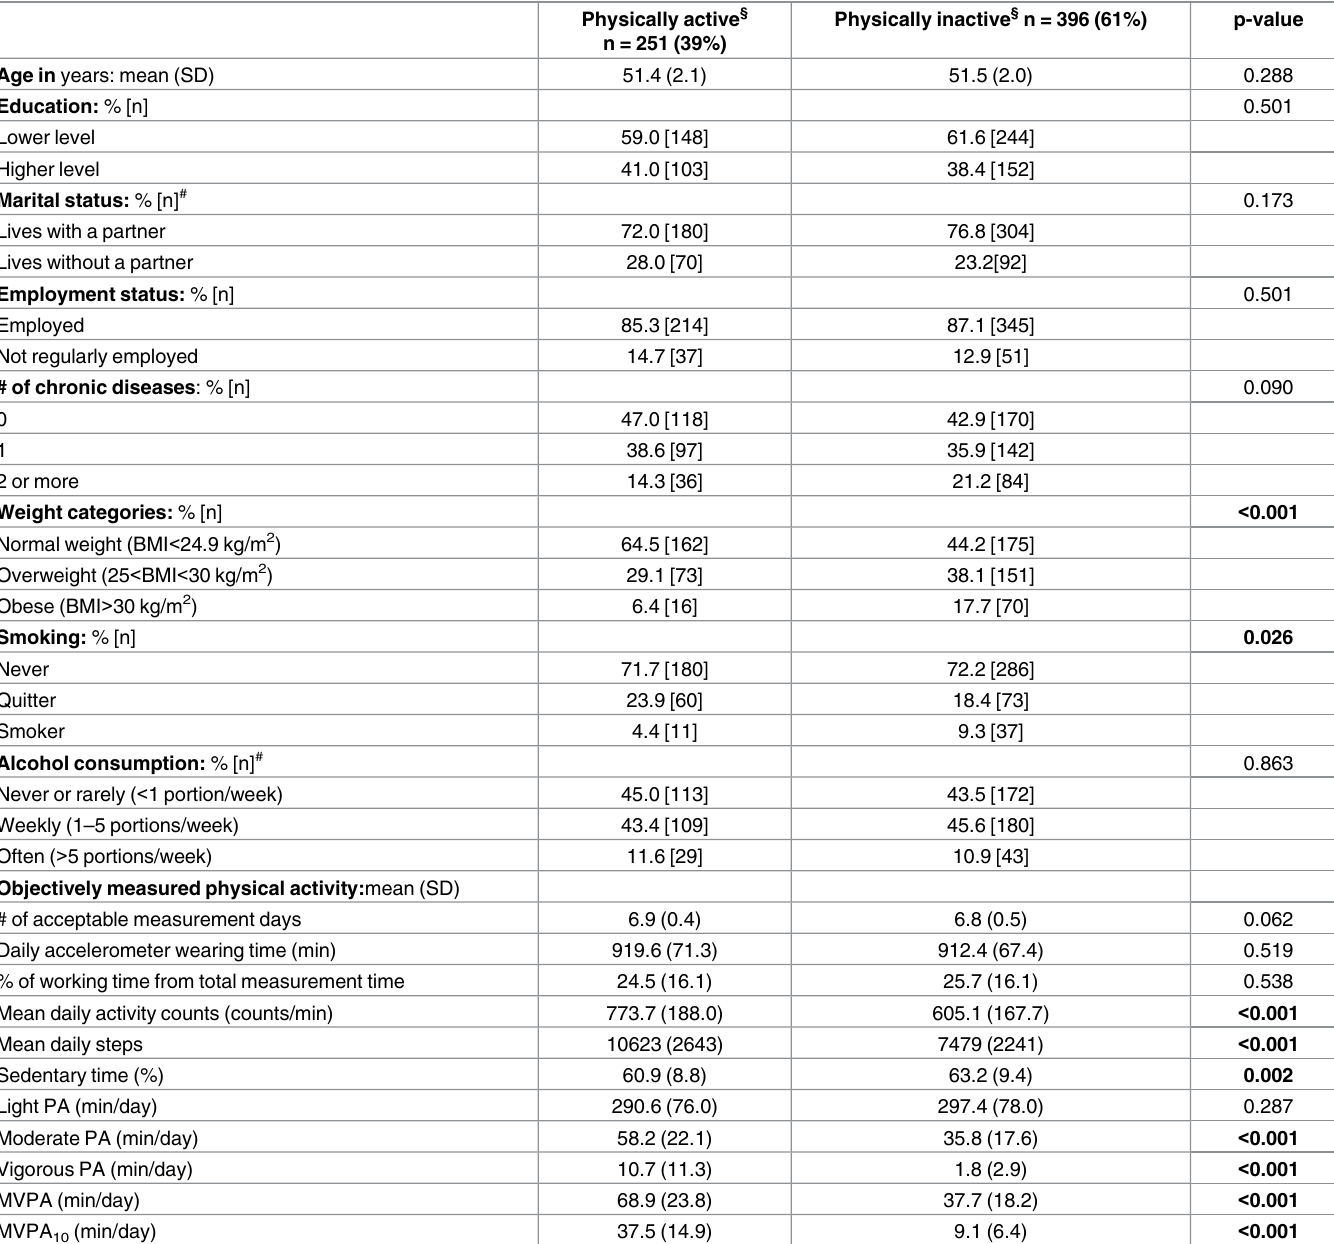
Table 1. General characteristics and physical activity of women in the physically active and inactive